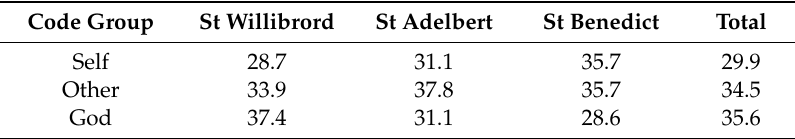
Table 10. Dimensions of everyday practices and monastic context. Code Group